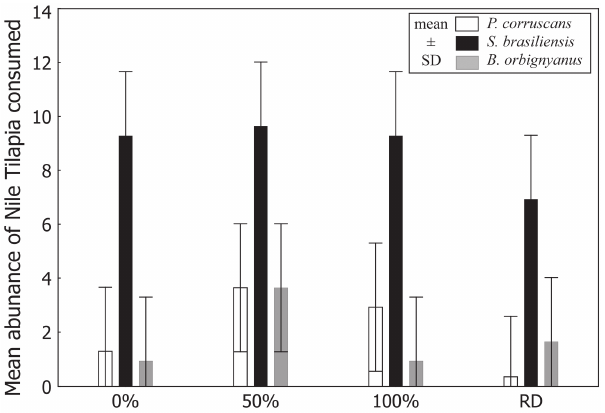
Fig. 3 . Predatory efficiency (mean ± standard deviation (SD) of Oreochromis niloticus consumption) by Pseudoplatystoma corruscans (white bars), Salminus brasiliensis (black bars) and Brycon orbignyanus (gray bars), in 0%, 50%, 100% and RD treatments. ANOVA for these data was not significant (P = 0.69) for interaction between species and structural complexity. However, the predatory efficiencies of species were different (P < 0.001).